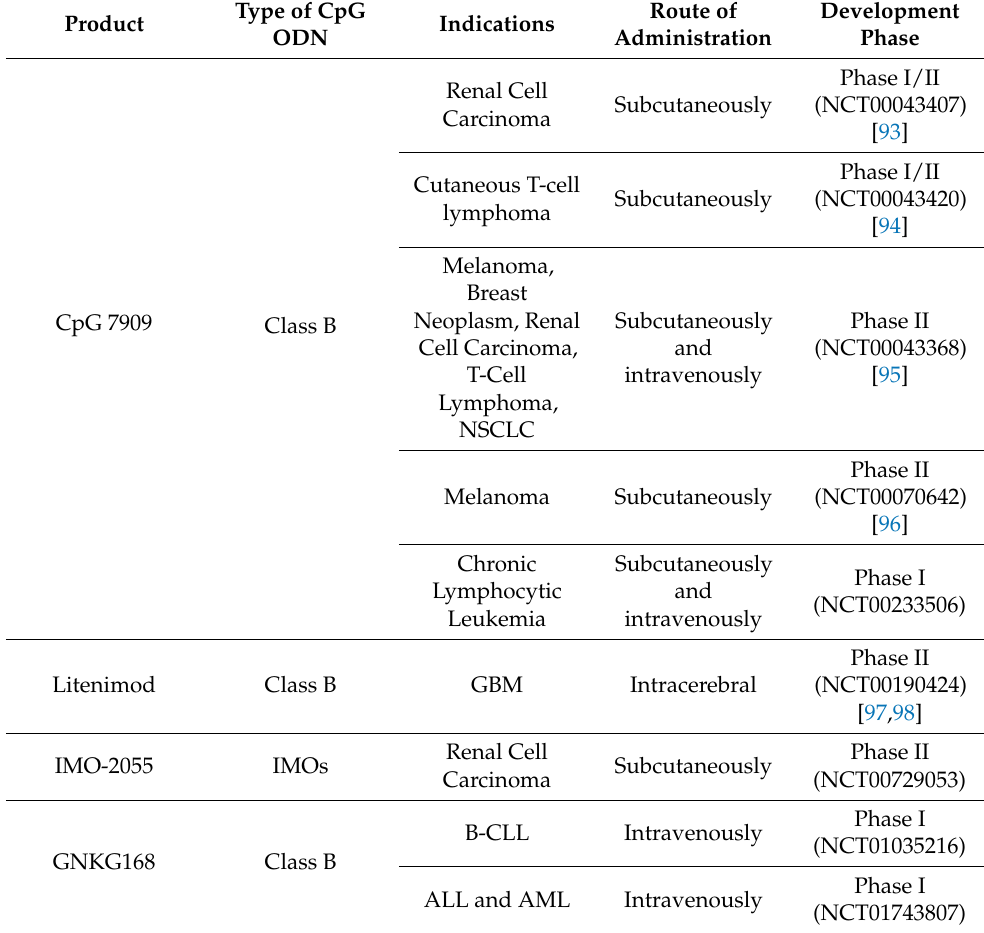
Table 1. CpG ODN monotherapy in current clinical